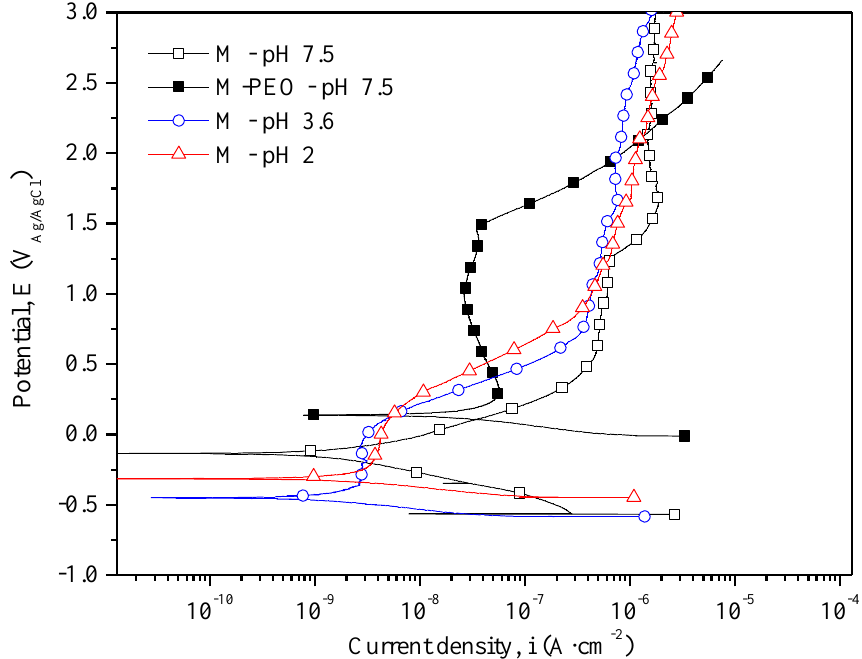
Figure 17. Potential vs. current density (E and i, respectively) during potentiodynamic polarization experiments of bare molten surface at pH 7.5, 3.6 and 2. PDP curve of M-PEO at pH 7.5 is also given for comparison.